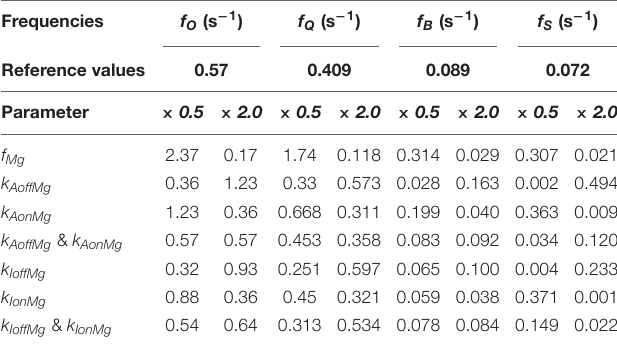
TABLE 4 | The effect of Mg-binding parameters on the frequency of occurrence of spontaneous calcium release events.